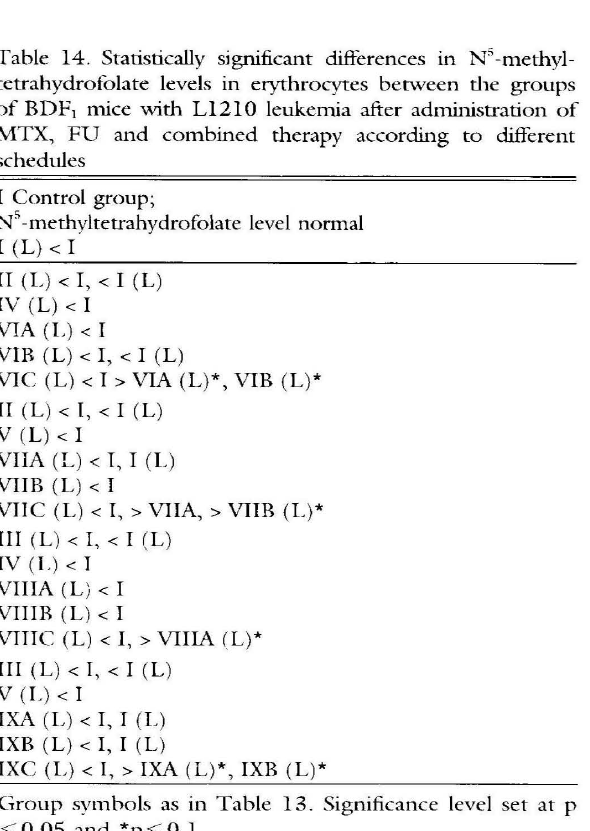
Group symbols as in Table 13. Significance level set at p S O,05 and *p S